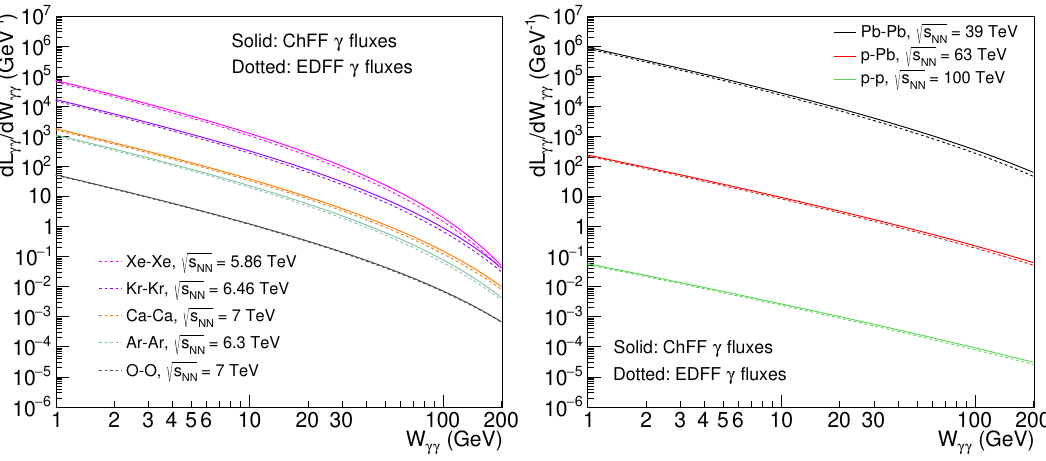
Figure 5 . Comparison of the e (cid:11) ective photon-photon luminosities d L (cid:13)(cid:13) = d W (cid:13)(cid:13) as a function of W (cid:13)(cid:13) , eq. (2.6), for UPCs of various ion species at the LHC (left) and for p-p, p-Pb, and Pb-Pb collisions at the FCC (right). Solid and dotted curves are obtained using ChFF and EDFF photon fluxes,